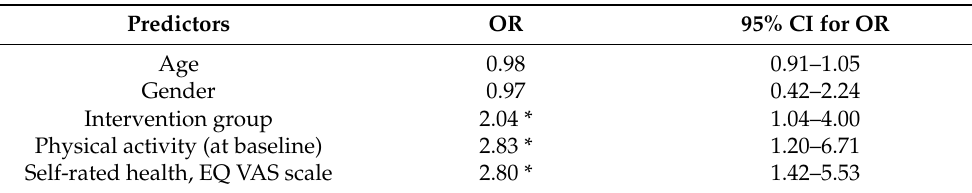
Table 3. Final logistic regression model showing independent variables associated with the level of physical activity, n =